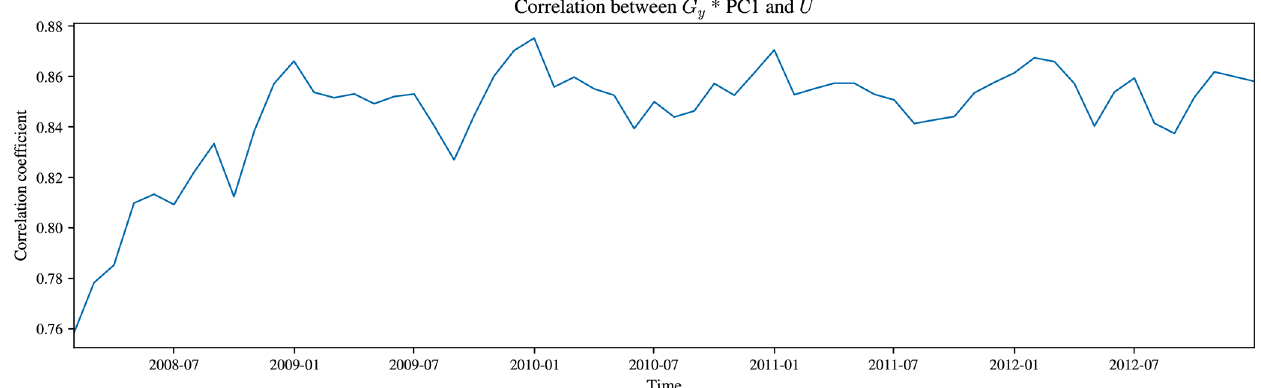
Figure A2. The correlation between G x ∗ PC1 and the zonal velocity, U , at 2m for each monthly mean in the B-SOSE iteration 106 dataset. The increase in the correlation over the first 2 years could be interpreted as the spin-up.